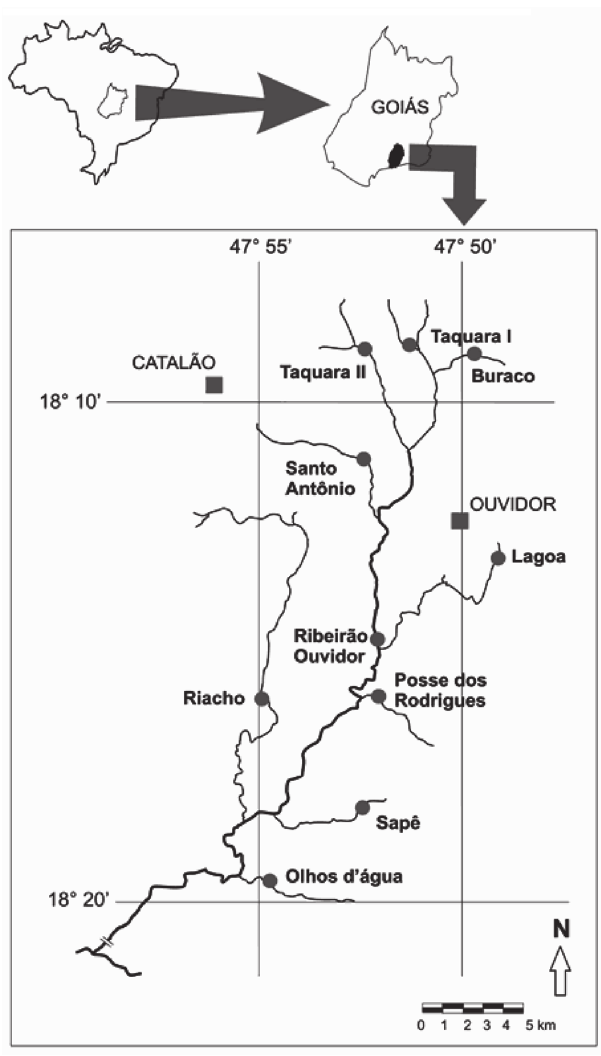
Fig. 1. Locations of the sampled sites (dots) in the streams of the Ouvidor River, Goiás State, Brazil. Squares indicate the main cities.